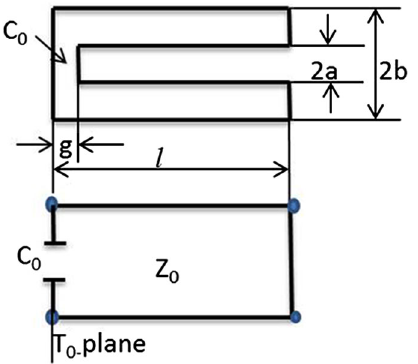
FIG. 7. Normalized required tuning amount (for tapers and stub tuners) verses cavity length, the curve inflection is due to the tuning range going to other direction from the target